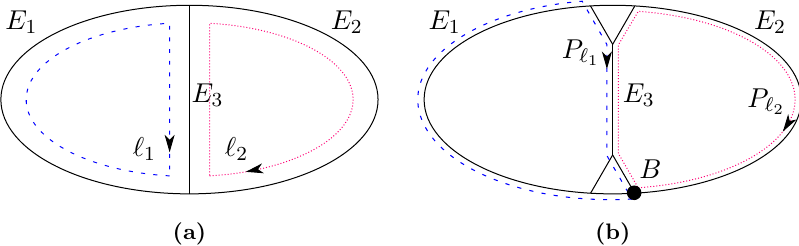
Figure 7. The graph (cid:0) with n = 0, g = 2 comes with a homology basis of two loops ‘ 1 and ‘ 2 ((cid:12)gure 7a); these can be used to de(cid:12)ne paths P ‘ end at the base point B (marked as a black dot on (cid:12)gure